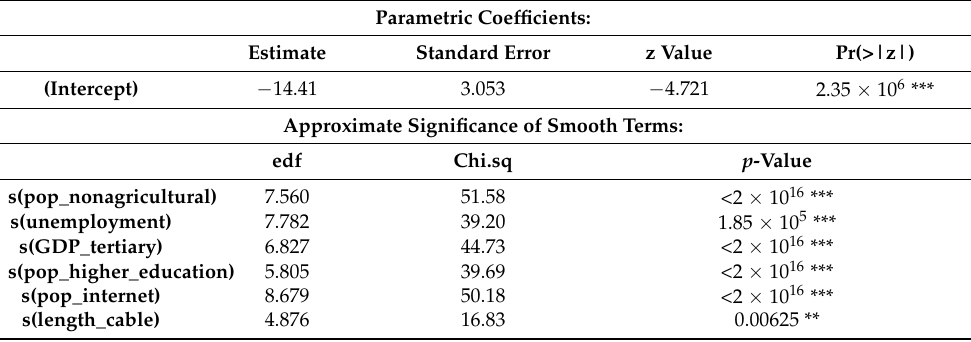
Table 2. Results of the final GAM model. Family: poisson; link function: log; formula: case_counts ~ s(pop_nonagricultural) + s(unemployment) + s(GDP_tertiary) + s(pop_higher_education)